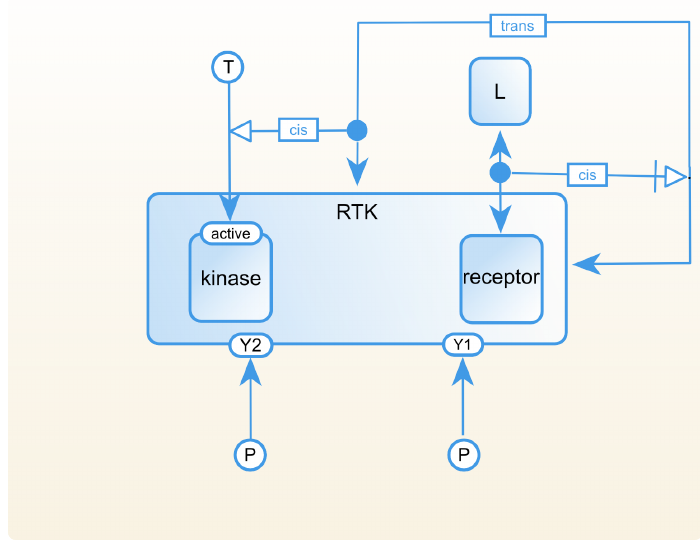
Figure A.6: Receptor tyrosine kinase activation: activation of the kinase domain of the